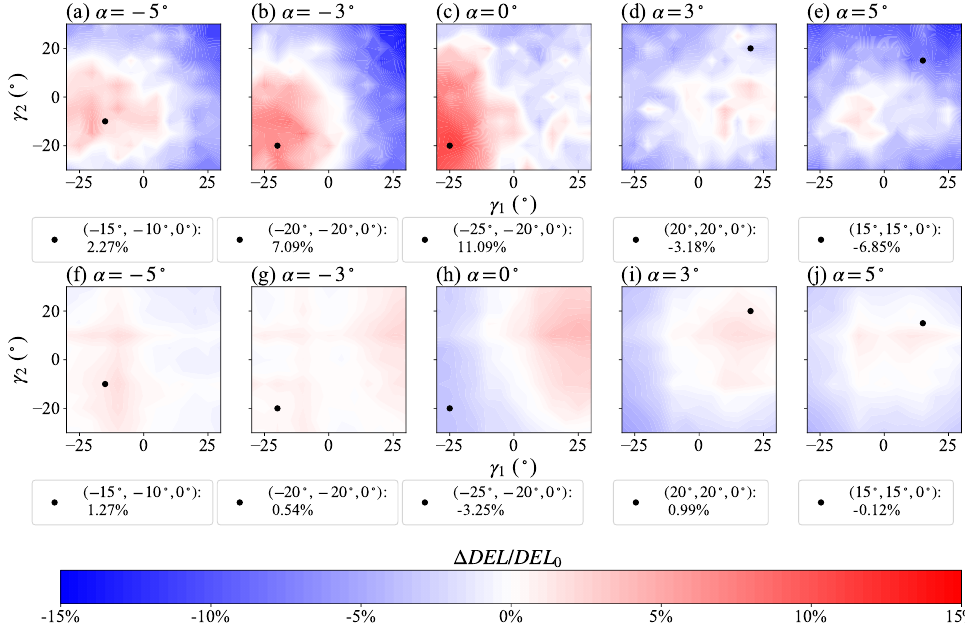
Figure 10. Normalised DEL variation contours in the AYC decision space Γ for different inflow angles for the ( a – e ) flapwise bending moment and ( f – j ) edgewise bending moment. Black dots show the power-optimal AYC configurations and their corresponding DEL